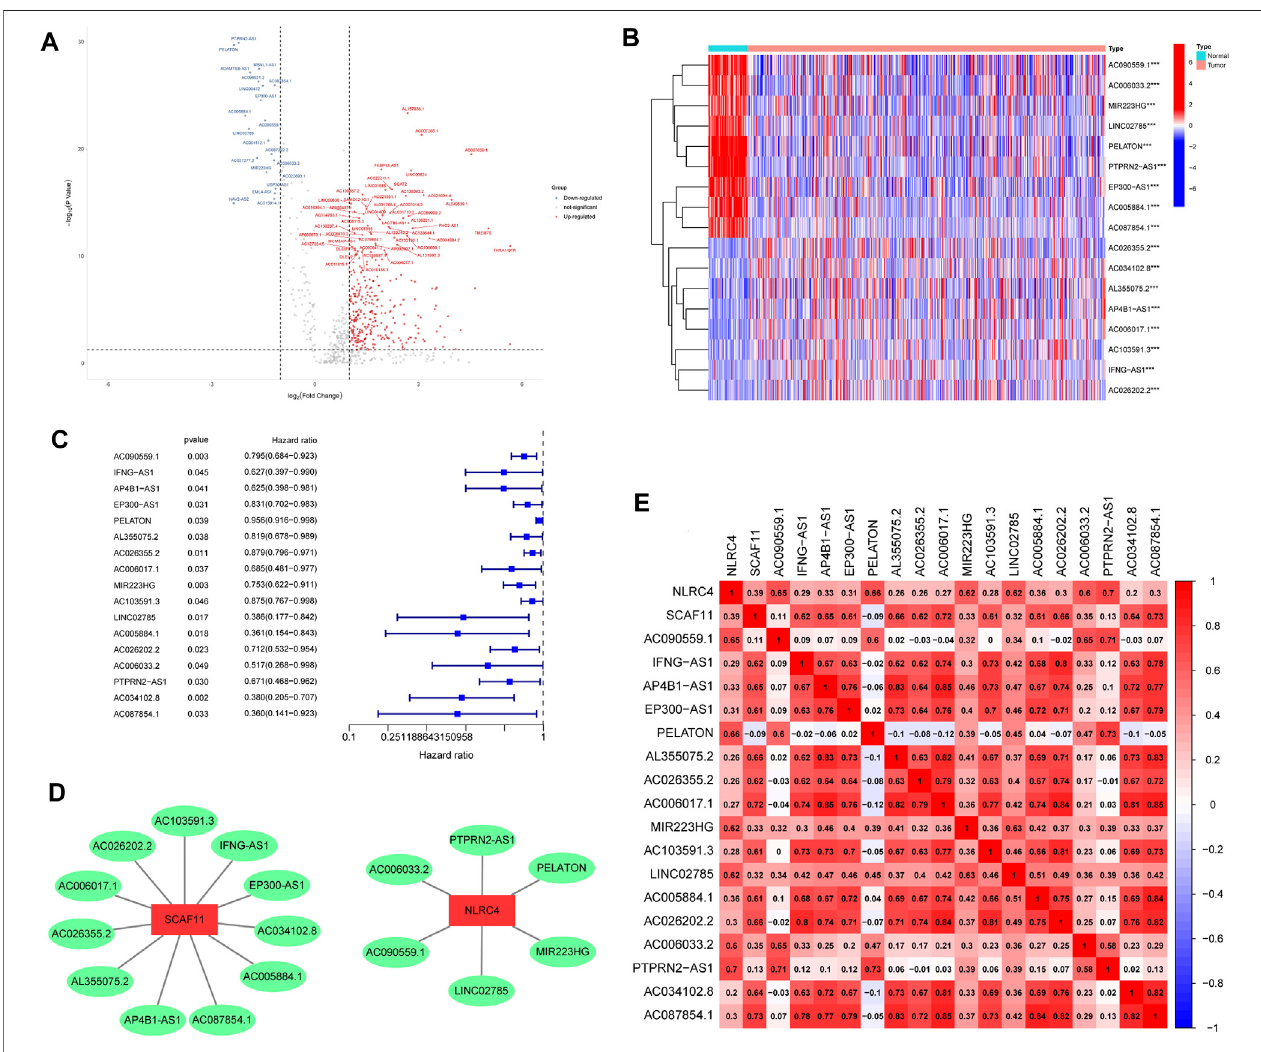
FIGURE 2 | Identi fi cation and characteristics of pyroptosis-related lncRNAs. (A) Volcano plot showing the differently expressed pyroptosis-related lncRNAs. (B) Heat mapvisualizesthedifferentialexpression ofprognosticpyroptosis-related lncRNAs betweennormalandLUAD. (C) Forest plotshowingtheresultofunivariateCox regression analysis for screening prognosis-related lncRNAs ( p < 0.05). (D) Interaction network of the 17 prognostic prognosis-related lncRNAs – mRNAs. (E) Visualization of prognosis-related lncRNA – mRNA correlation. *** p < 0.001, LUAD, lung adenocarcinoma.